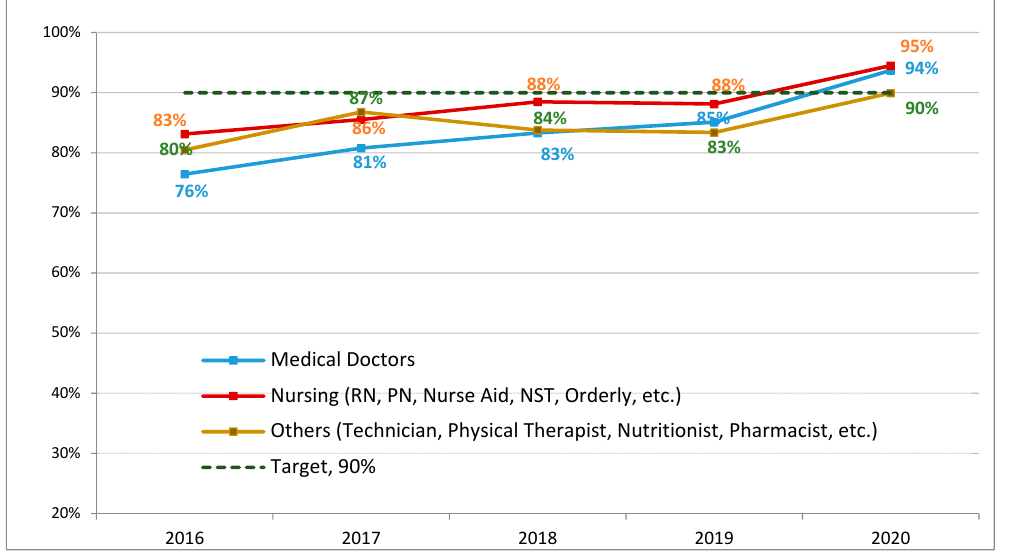
Figure 4. Hand hygiene compliance rates 2016–2020 based on anonymous audits. RN, registered nurse; PN, practical nurse; NST, nurse technician.